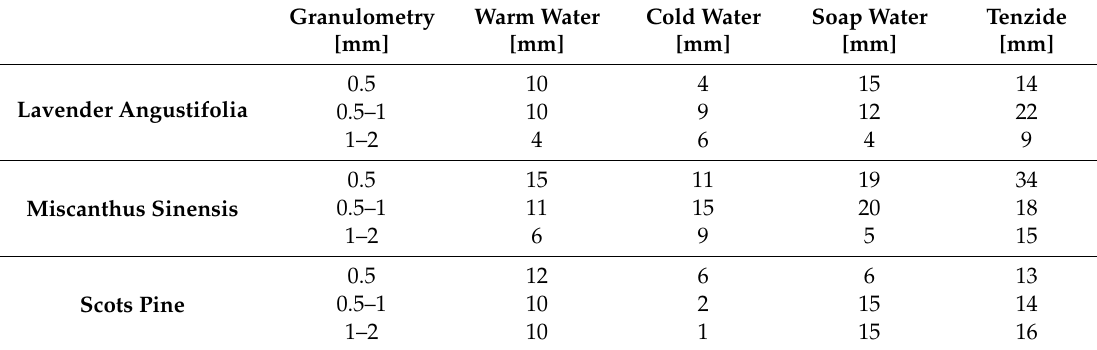
Table 3. Maximum values of absorptivity.